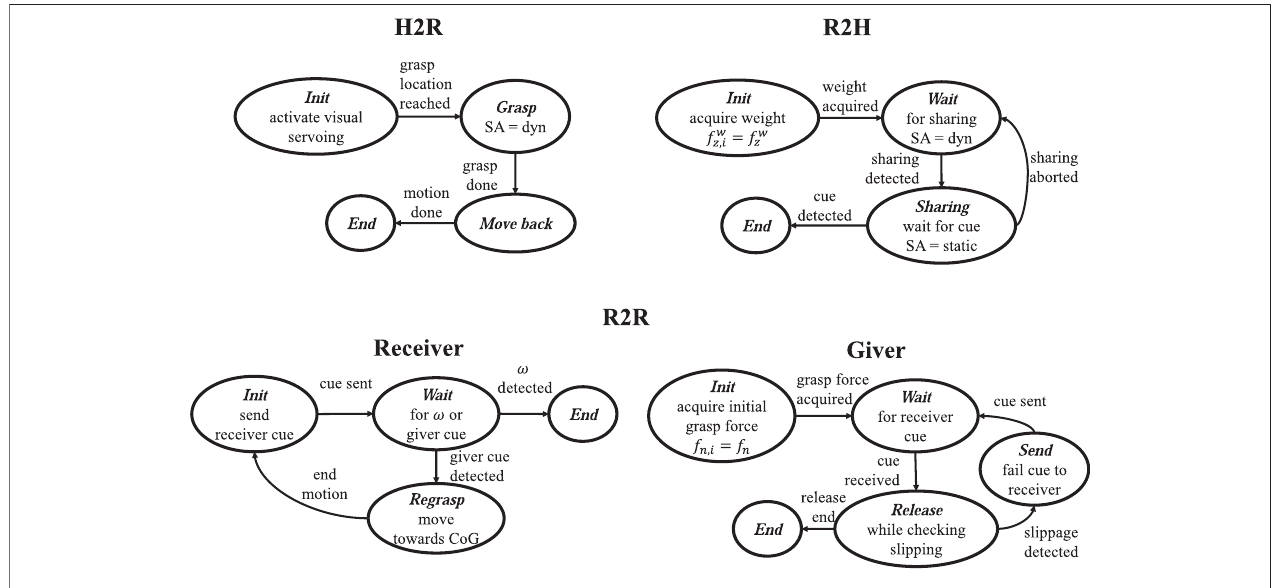
FIGURE 4 | FSMs for the handover algorithms: name of the states in boldface italic.